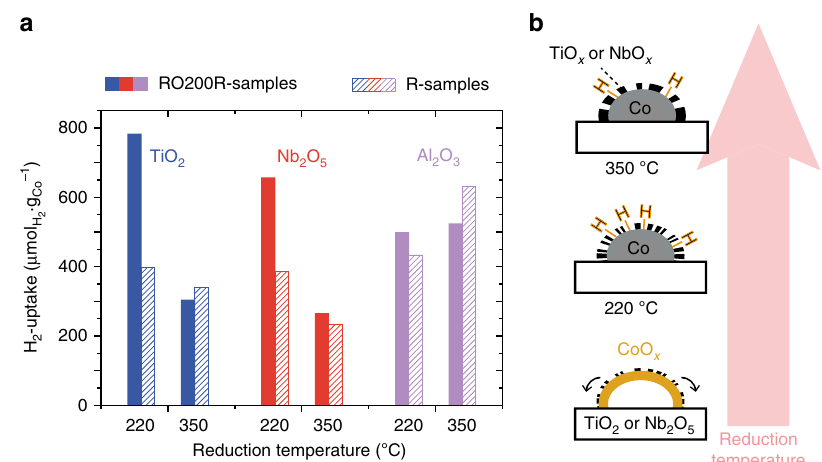
Fig. 4 The in fl uence of the temperature of the second reduction on the exposed cobalt surface area. a Hydrogen uptake as a function of the second reduction temperature. Dashed bars correspond to the pristine samples after reduction at 220 or 350 °C and solid fi lled bars correspond to the samples after reduction at 350 °C followed by oxidation at 200 °C and reduction at 220 or 350 °C. b Schematic illustration of the effect of the reduction temperature on catalysts supported on reducible